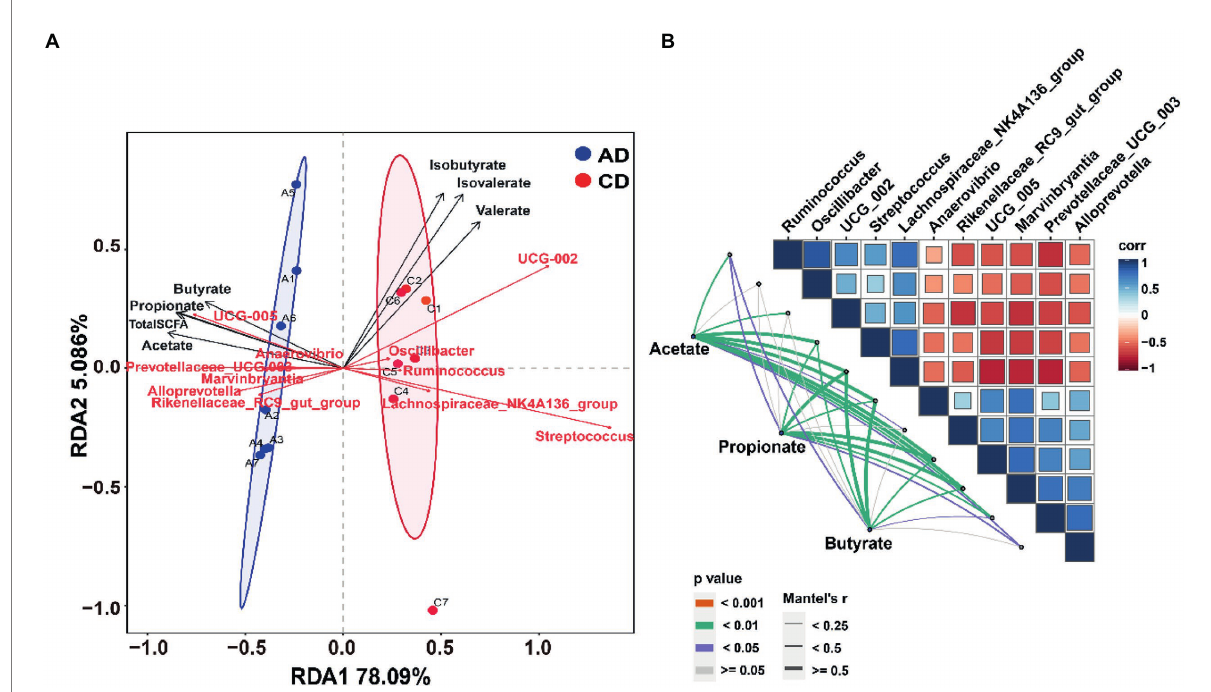
FIGURE 7 Correlation analysis of microbiota and SCFA. (A) Redundancy analysis of the colonic microbiota composition at genus level relative to colonic SCFAs; (B) Pairwise comparisons of different genera are demonstrated with a color gradient denoting Spearman’s correlation coefficient. Acetate, propionate, and butyrate are related to each microbial genus by Mantel’s correlation analysis. CD, control diet; AD, alfalfa diet.